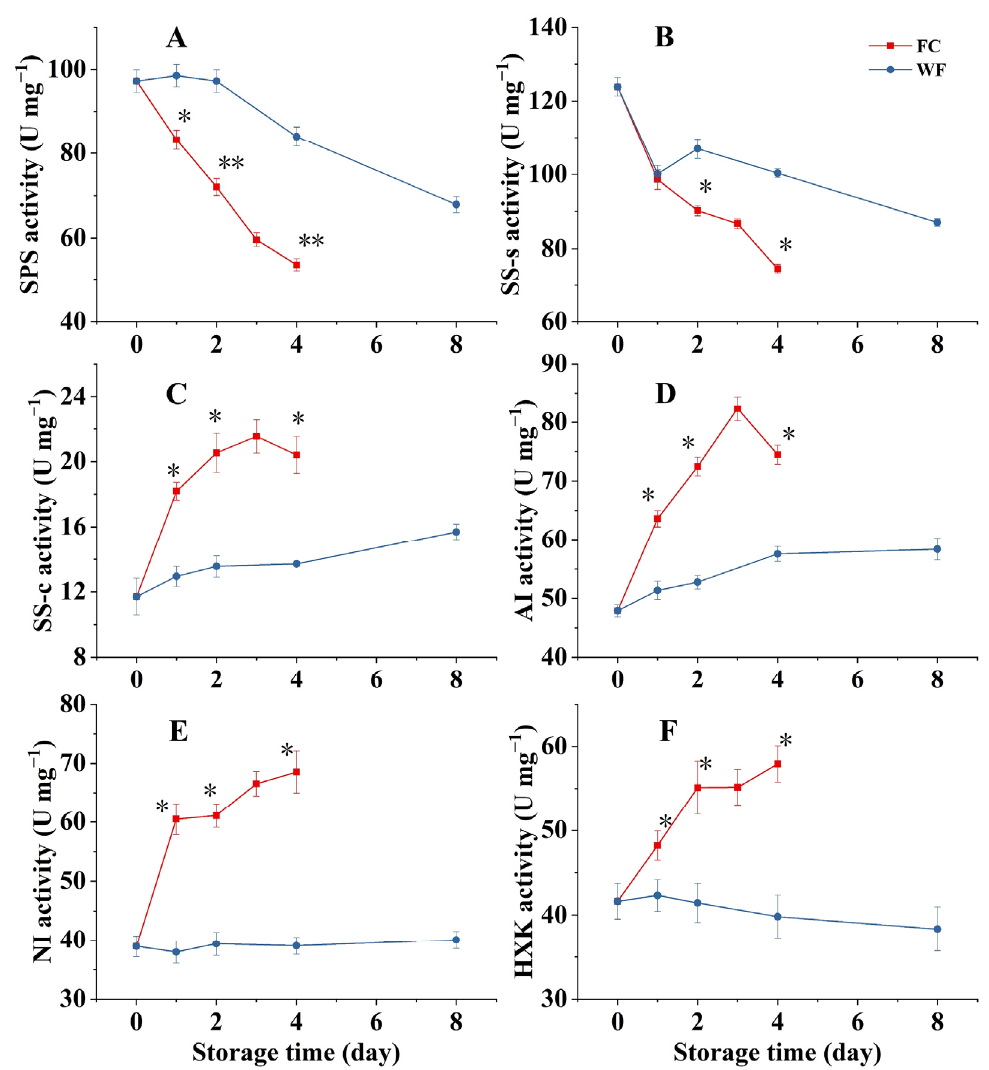
Figure 2. Effect of cutting on the activities of ( A ) sucrose phosphate synthase (SPS), ( B ) sucrose synthase-synthesis (SS-s), ( C ) sucrose synthase-cleavage (SS-c), ( D ) acid invertase (AI), ( E ) neutral invertase (NI) and ( F ) hexokinase (HXK) in melon fruit during storage (15 ◦ C). FC and WF respectively represent fresh-cut and whole melon fruit. The values are expressed as means ± SE of three replicates. * and ** indicate statistically significant differences ( p < 0.05 and p < 0.01 respectively) according to Student’s t -test at each sampling point.